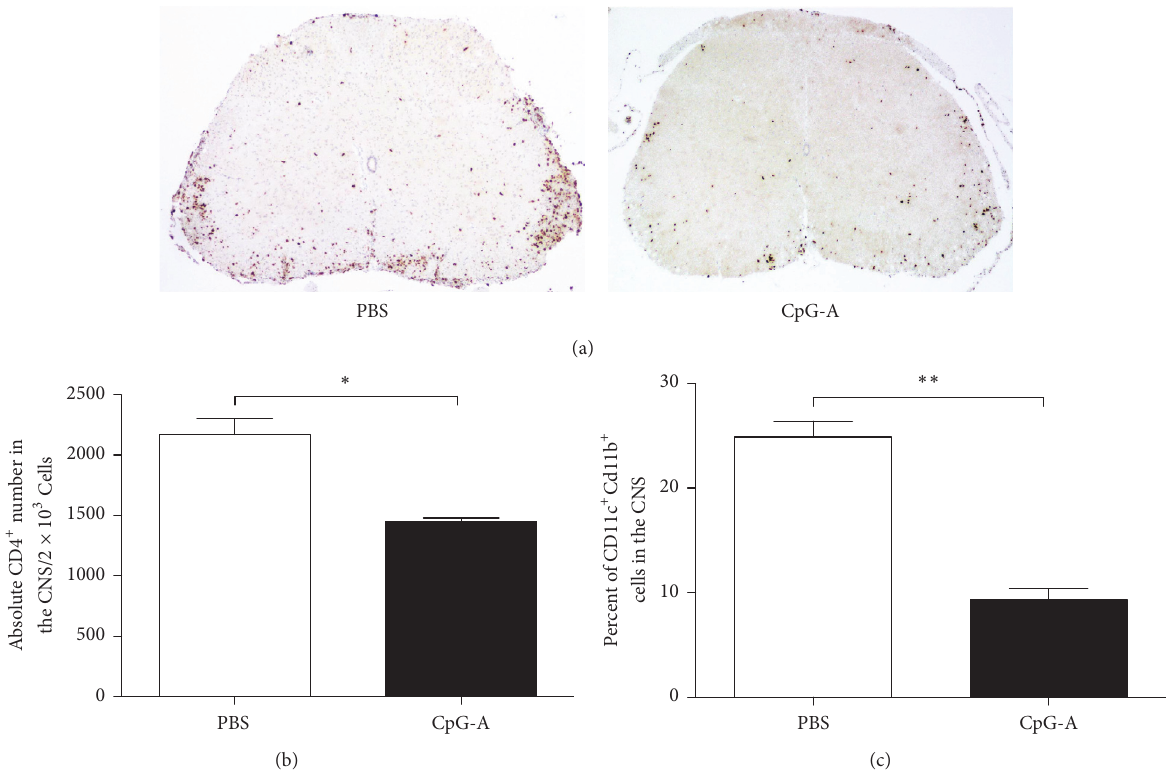
Figure 3: Decreased CNS lymphocyte infiltration in mice treated with CpG-A during EAE. (a) Representative images of spinal cross sections at peak of disease in specific groups (indicated). Stained CD4 + T cells are shown. Images are representative of one experiment out of three; 𝑛 = 4 mice per group. Quantification of spinal cord immune-cell infiltration at day 20 after immunization in mice treated with PBS or CpG- A, CD4 + cells. (b) CD11b + /CD11c + . (c) Showed is the mean ± sem of two independent experiments; 𝑛 = 7 per group. ∗ 𝑝 < 0.05 , two-tailed Mann–Whitney test. ∗∗ 𝑝 < 0.01